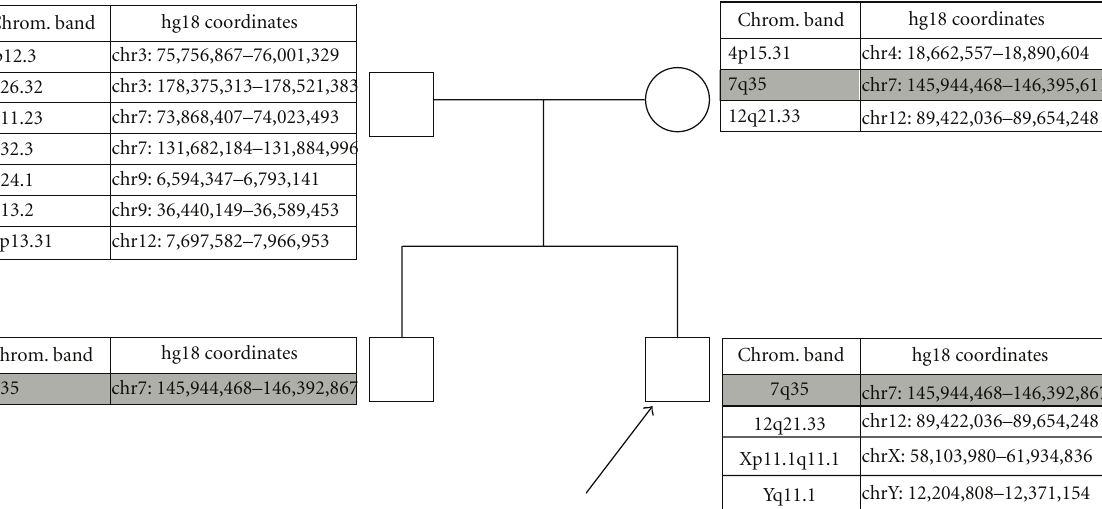
Figure 2: Pedigree of proband and copy number changes. The copy number changes detected in all members of the pedigree are shown; the common deletion detected in the CNTNAP2 gene is shown in grey, and the proband is indicated by an arrow. molecular karyotype result. He is the second child born to a nonconsanguineous European couple with normal language development. The proband’s perinatal history